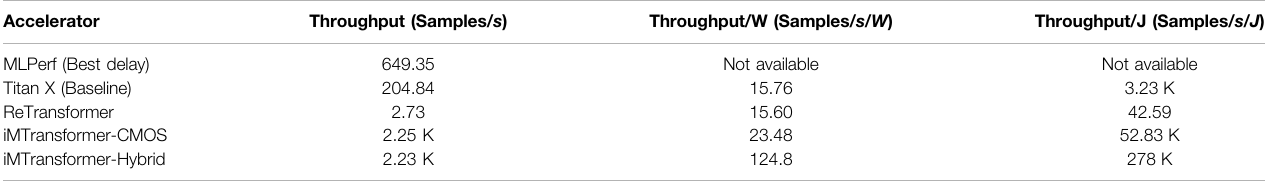
TABLE 3 | Comparison of the leading MLPerf Inference - Edge results, the Titan X baseline, ReTransformer and the CMOS-based and Hybrid iMTransformer using MLPerf setting. MLPerf uses BERT-large and the SQuAD 1.1 dataset with a maximum sequence length of 384. Accelerator Throughput (Samples/ s ) Throughput/W (Samples/ s / W